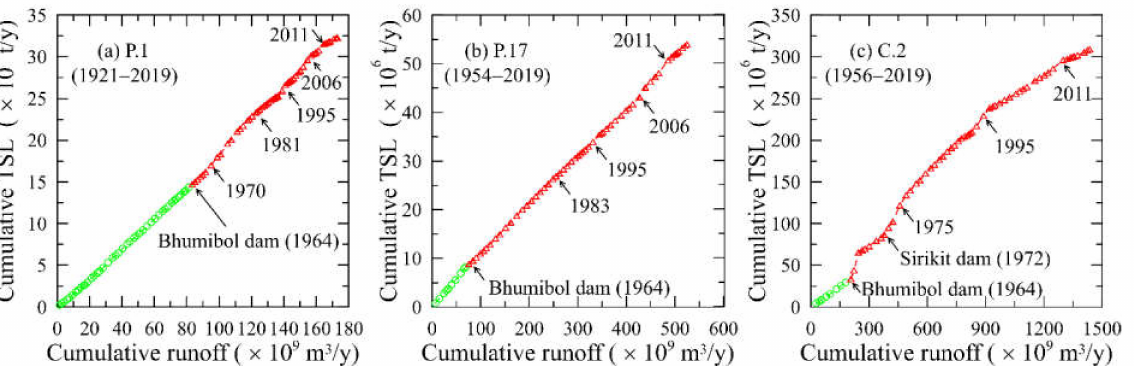
Figure 7. Cumulative annual runoff and total sediment load of the Ping River: ( a ) P.1; ( b ) P.17; ( c ) C.2.; the green and red points represent the data during the pre- and post-construction of the Bhumibol Dam,